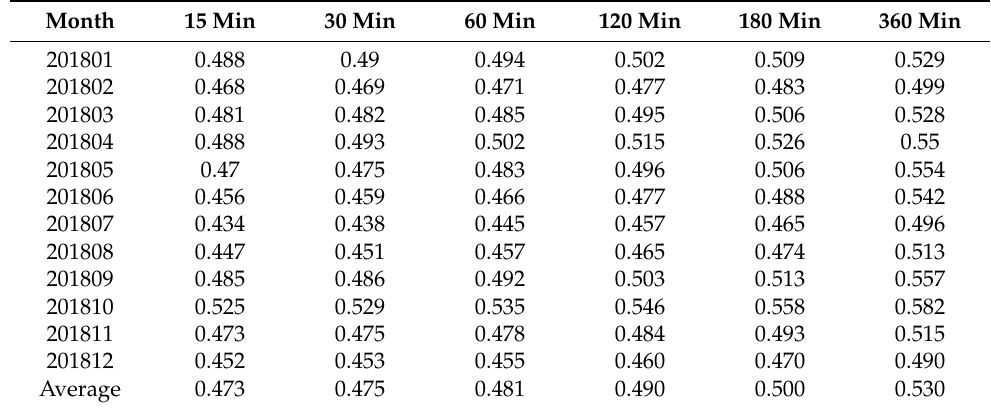
Table 4. Performance Evaluation on MAPE of the Real-Time D -day Forecast Over the Next 6 Hours.